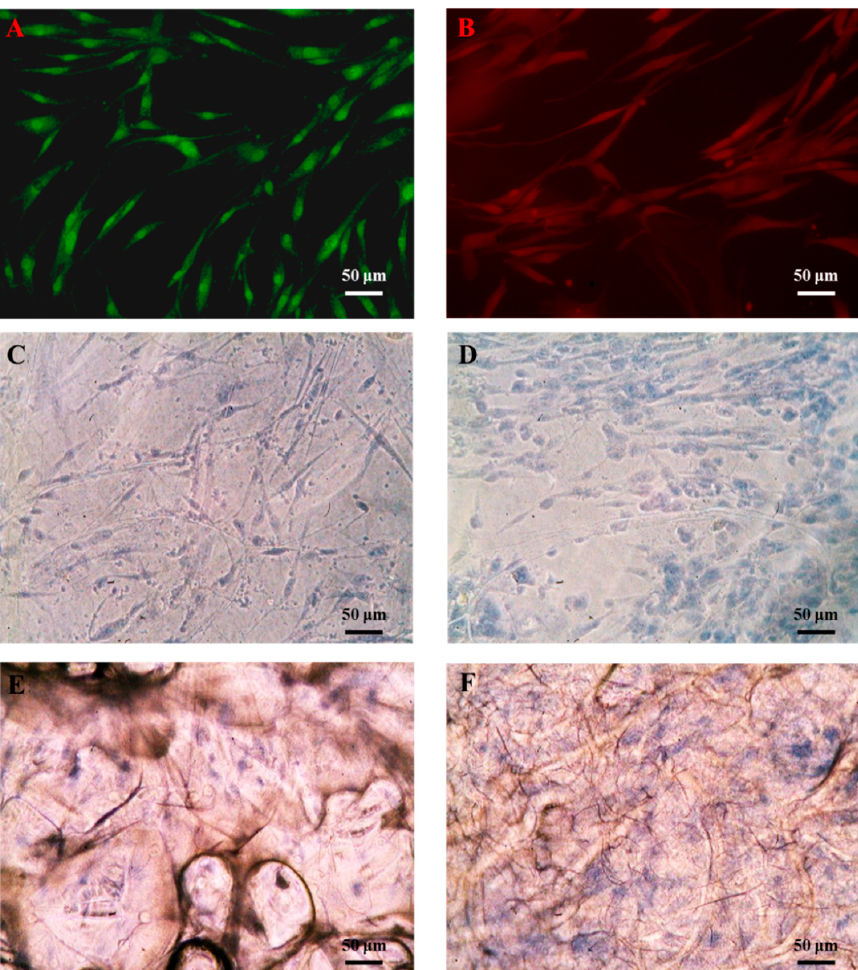
Figure 5. Immunofluorescence staining of stem cells in the presence of hASCs. ( A ) Octamer-binding transcription factor 4 (OCT-4) and ( B ) bone morphogenic protein (BMP)4. Trypan blue staining of hASCs grown on biomaterials for 7 d. ( C ) BC, ( D ) BC/RSV, ( E ) COL, and ( F ) COL/RSV scaffolds. Scale bar = 50 μ m.